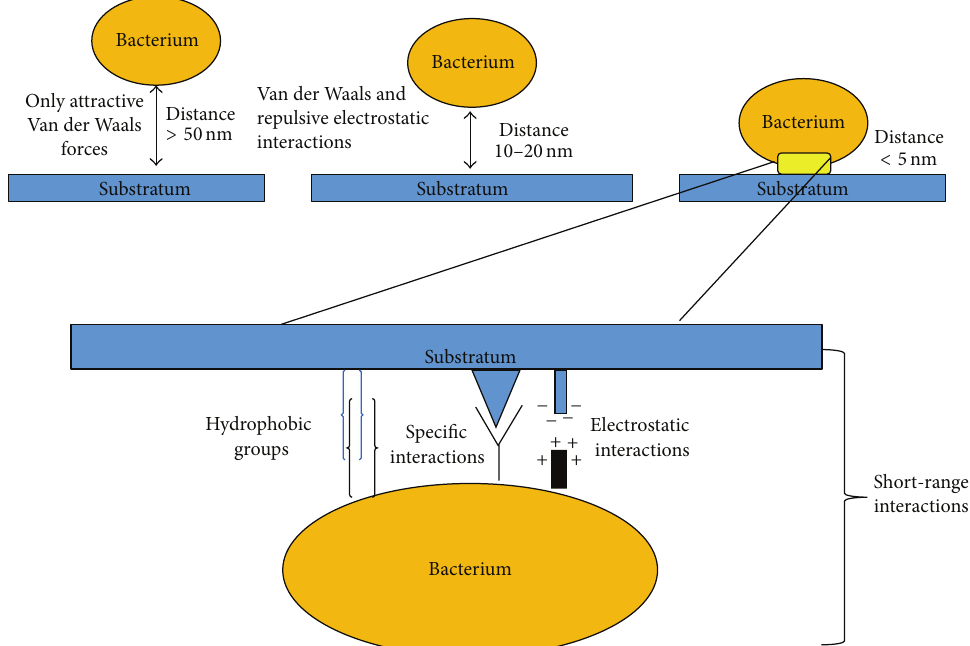
Figure 2: Phase one of bacterial adhesion consists in the initial attraction of the cells to the surface through the effects of physical forces. These physical interactions are further classified as long-range interactions (nonspecific, distances > 50 nm between cells and surfaces) and short- range interactions (distances < 5 nm, with involvement of hydrogen bonding, ionic and dipole interactions, and hydrophobic